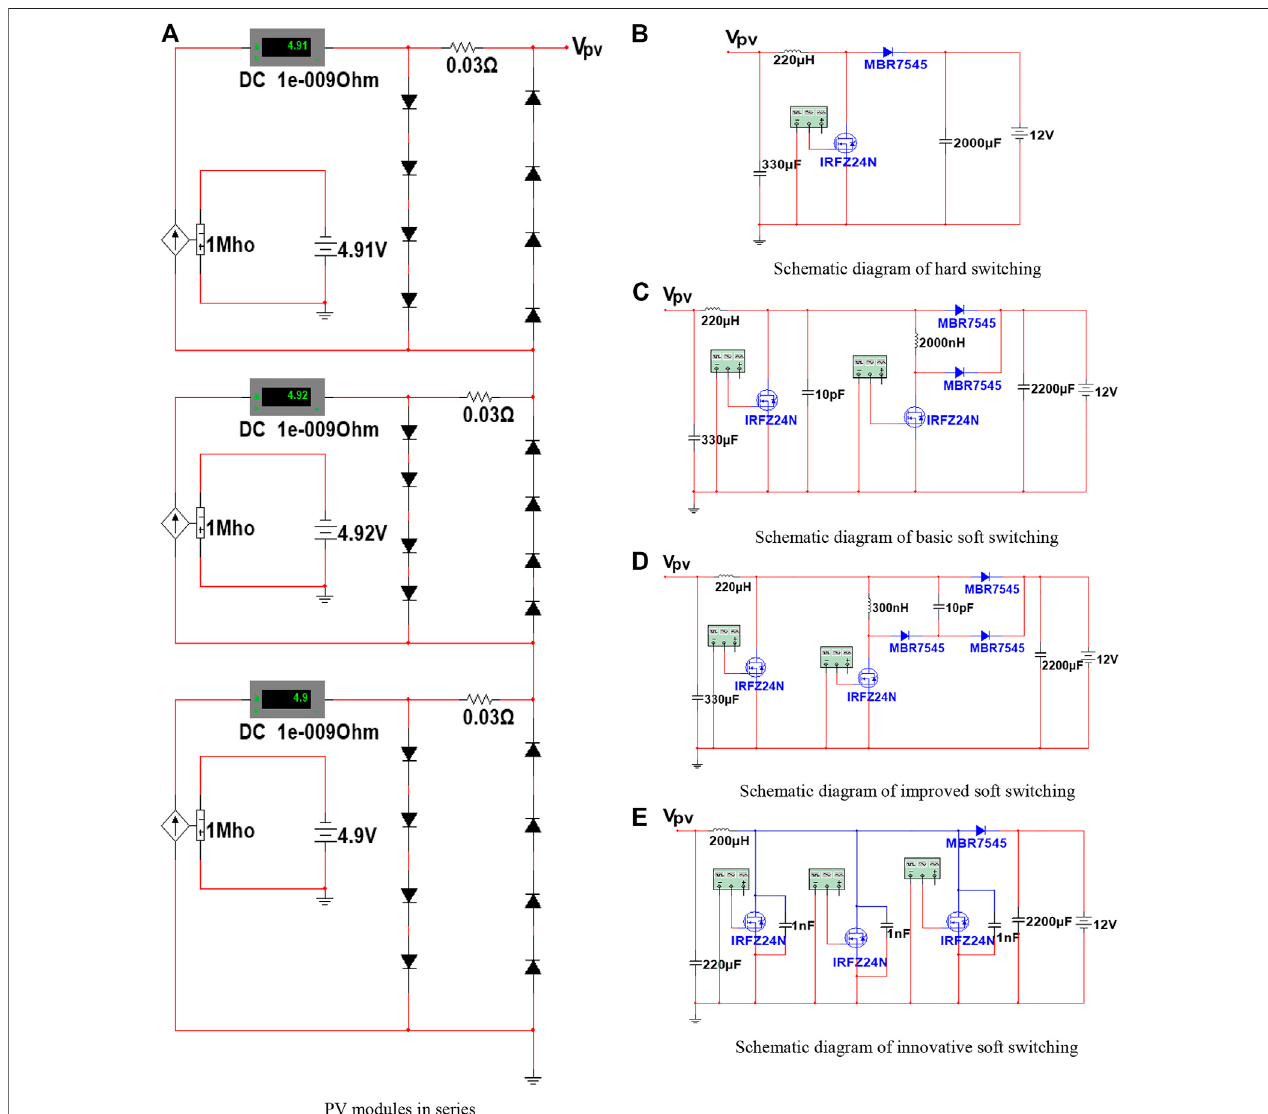
FIGURE 11 | Hard switching input and output power